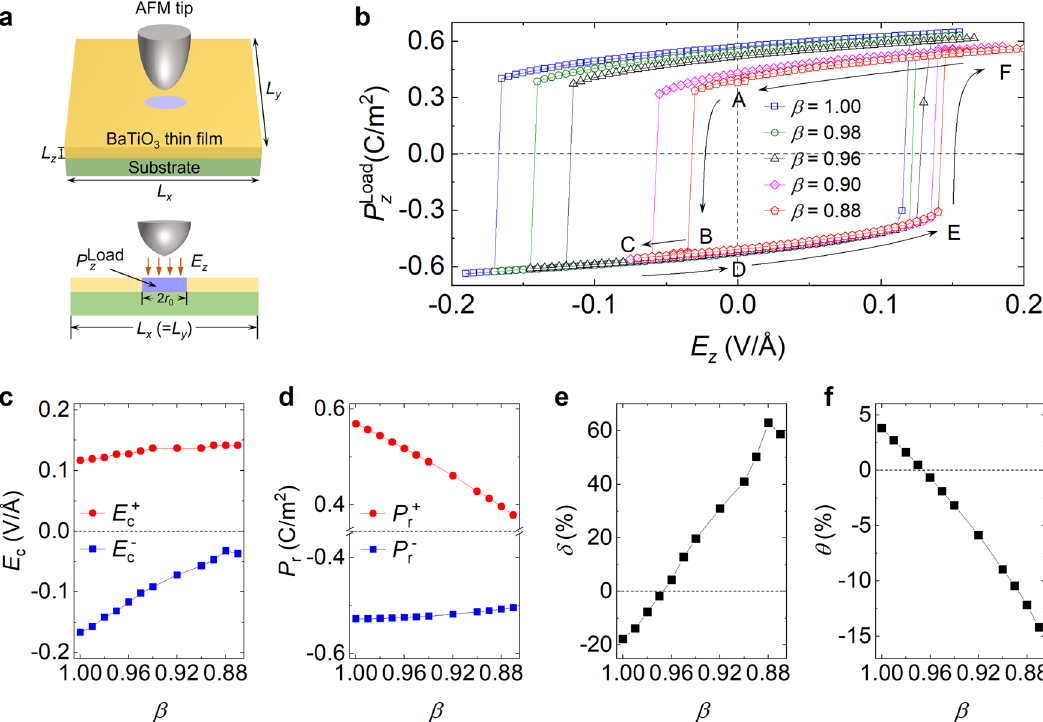
Fig. 3 Local hysteresis loops under different surface screening conditions. a Schematic of local electrical switching. b The simulated local hysteresis loops under selected β . c – f The β dependence of the coercive fi eld, remnant polarization, asymmetric parameter of the coercive fi eld, and asymmetric parameter of the remnant